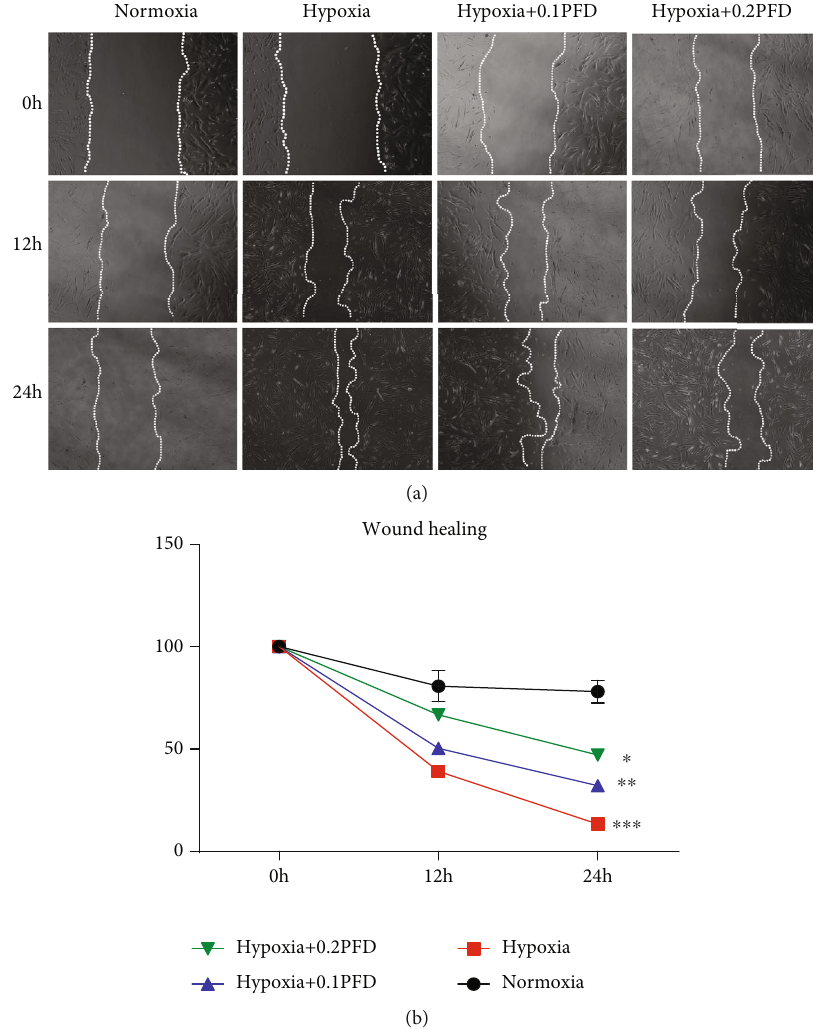
Figure 2: PFD treatment reduced HPAAF migration after 12 h or 24 h hypoxia exposure. HPAAFs were stimulated by PFD before hypoxia, and cell migration was analyzed by wound healing assay. (a, b) Results and quanti fi cation of wound healing assay in HPAAFs following 12h and 24h of treatment ( n = 3 ). ∗ P < 0 : 001 vs. normoxia; ∗∗ P = 0 : 004 vs. hypoxia; ∗∗∗ P < 0 : 001 vs. hypoxia. PFD: pirfenidone; HPAAFs: human pulmonary arterial adventitial fi